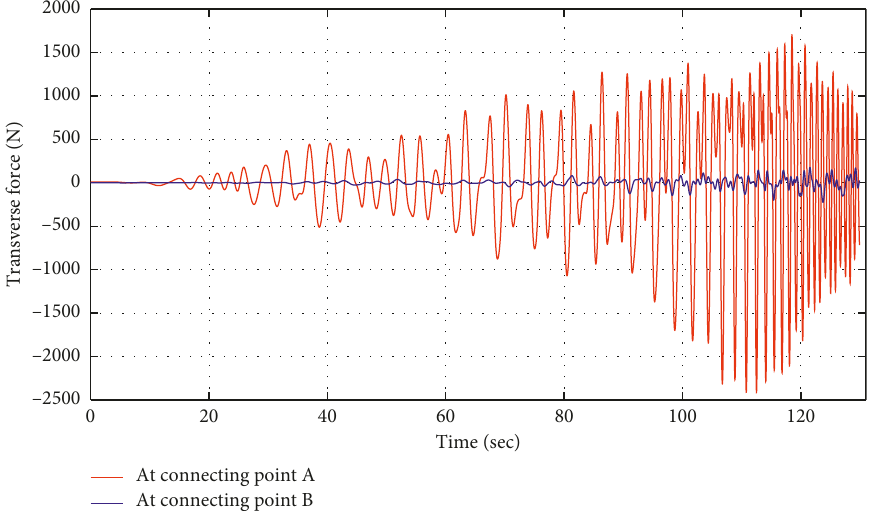
Figure 12: Transverse forces between the conveyance and ropes.